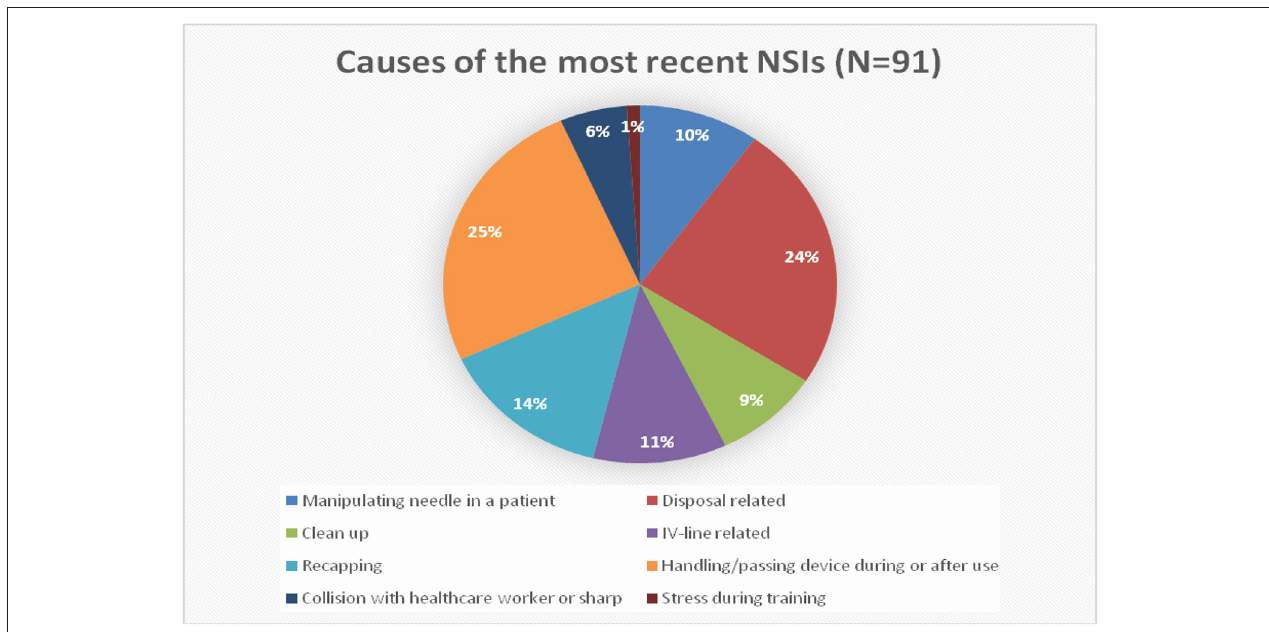
FIGURE 3 | Causes of the most reasons